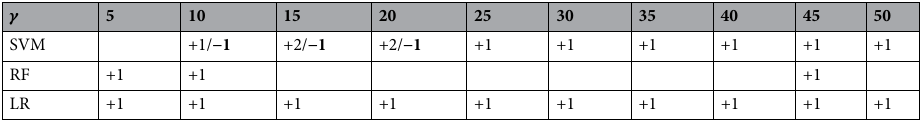
Table 7. Summary of the results, by classifier, for different values of the cost ratio γ = the boxes indicate for how many data sets, of the possible 3, there is statistical significance in favor of BOSME (positive) or in favor of ROSE (negative, in bold).